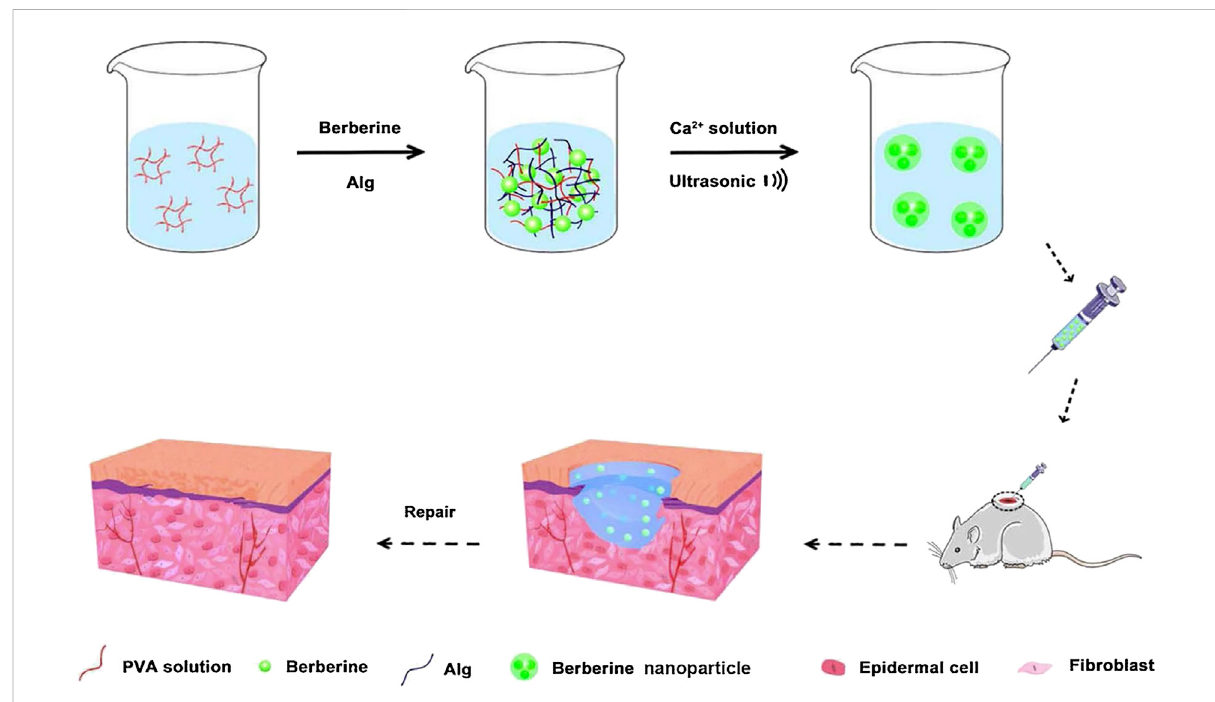
FIGURE 2 Preparation of a berberine nanohydrogel and its application to skin wound healing of diabetic rats. Reproduced from (Zhang et al., 2020), with permission from